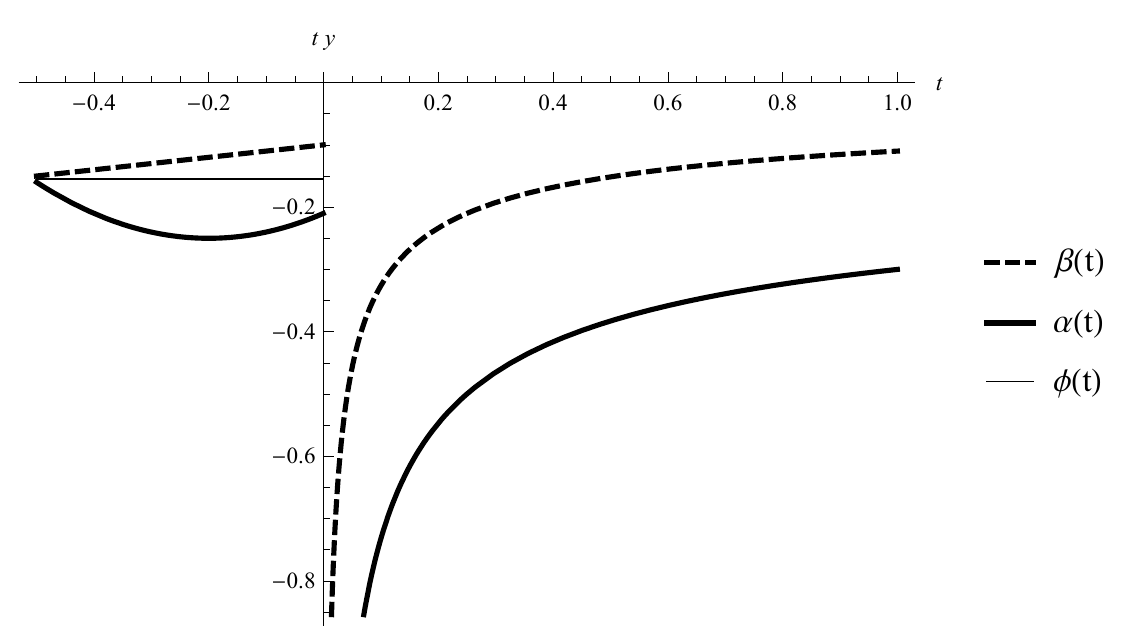
Figure 10. Eaxmple 2. Graphs of the functions α ( t ) , β ( t ) , φ ( t )